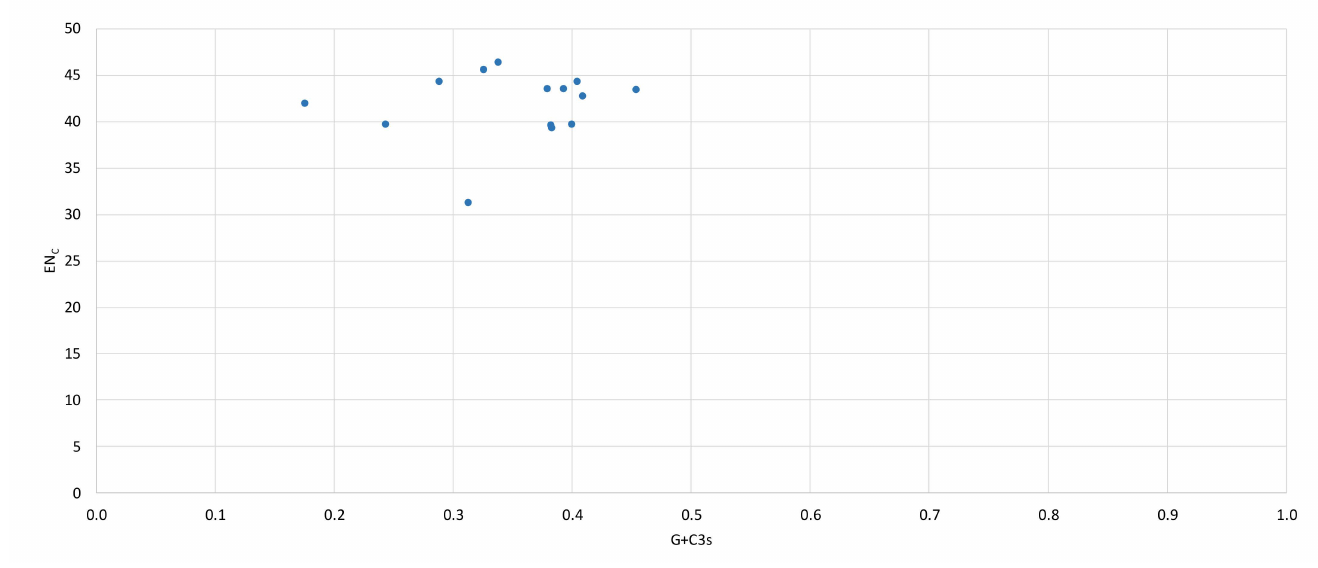
Figure 4. ENc-GC3s values plot for PCGs of the European mink mitochondrial genome (EN C — effective codon number, GC3—frequency of G − C nucleotides at the third codon